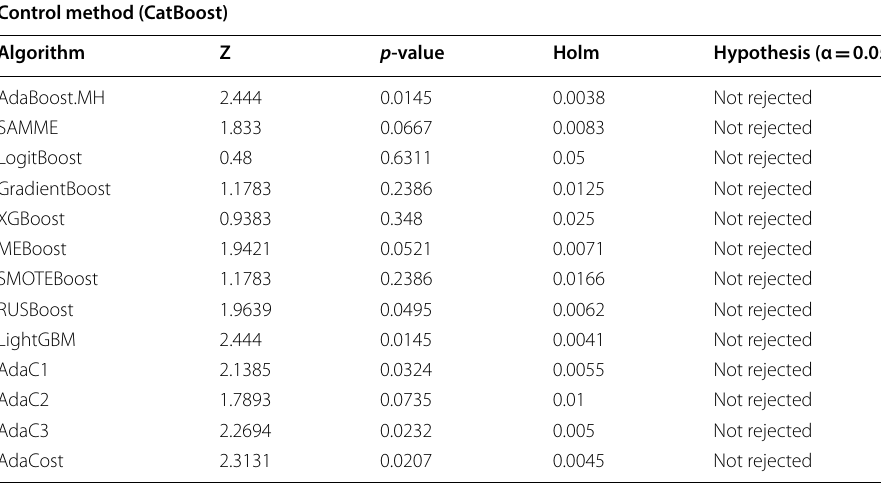
Table 8 Holm post-hoc test results based on the MMCCs Control method